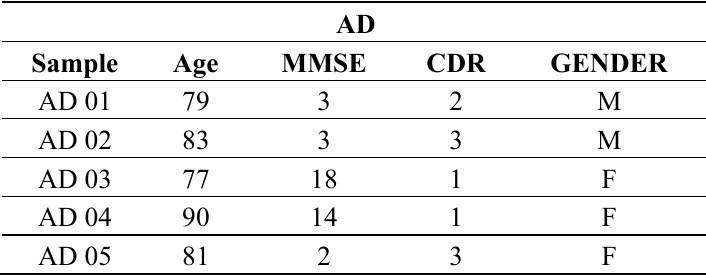
Table 2. Characterization of AD and EC patients, including age, clinical dementia rate (CDR) that identifies the stage of the disease: mild (1), moderate (2) or severe (3); mini-mental state examination score (MMSE): a method for grading the cognitive state of patients (0–30) and gender (M; male; F: